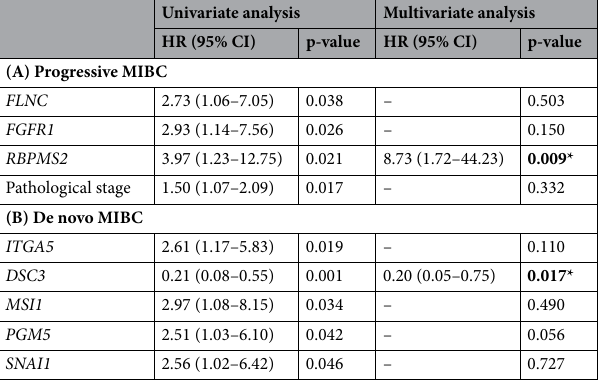
Table 3. Tumor progression in progressive and de novo MIBC patients. HR Hazard ratio, CI confidence interval. *Statistically significant values are in bold.